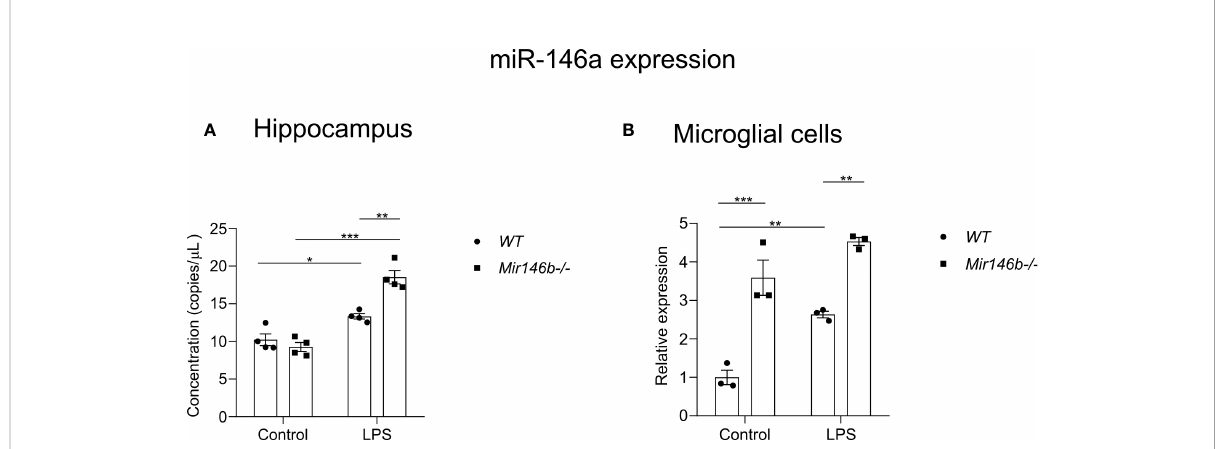
FIGURE 8 Basal and LPS-induced miR-146a expression in the hippocampal tissues and microglia of Mir146b-/- mice and WT littermates. (A) miR-146a expression in hippocampal tissues (B) miR-146a expression in microglial cells. Number of animals = 4 (A) and 3 (B) . * p=0.05, ** p<0.01, *** p<0.001. (Data in panel (A) were analyzed using two-way ANOVA with Tukey ’ s multiple comparisons test; data in panel (B) was analyzed using Welch ’ s ANOVA with Dunnett ’ s multiple comparisons